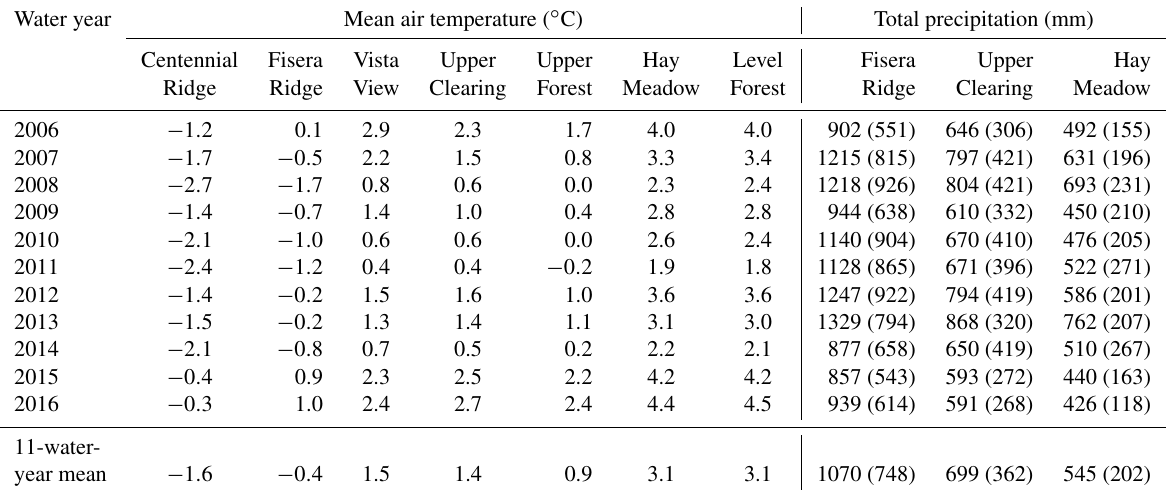
Table 4. Mean water year air temperature and total water year precipitation from the current stations at the Marmot Creek Research Basin. Values inside parentheses are total water year